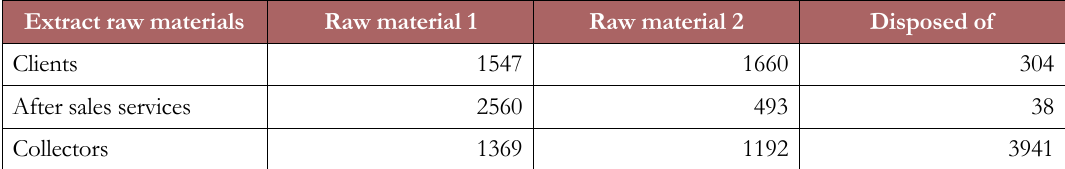
Table 5. Values of extracted material depending on the source of